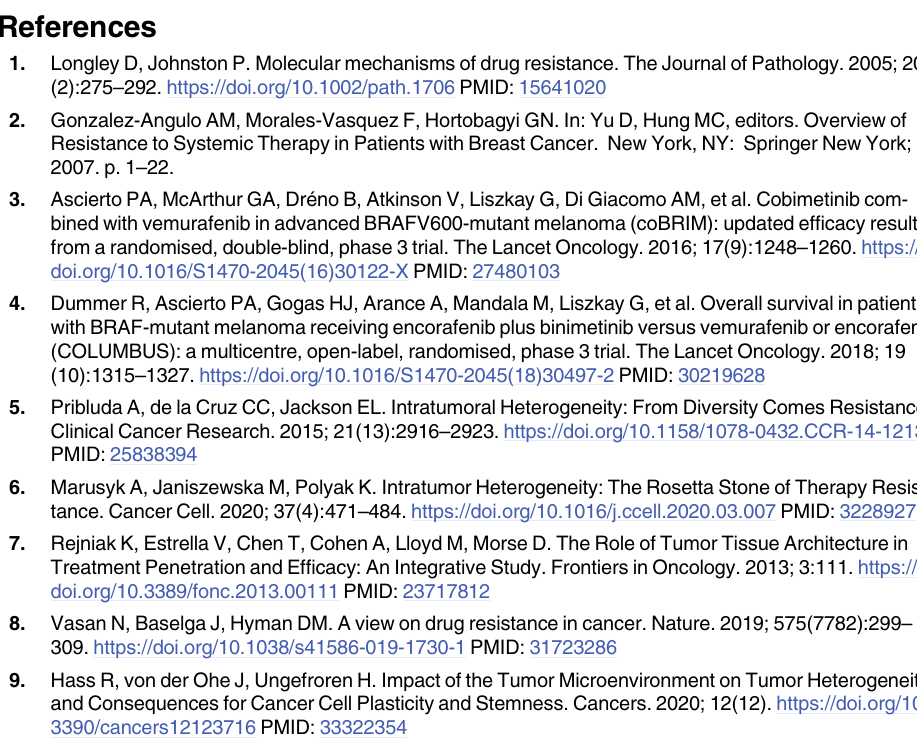
S4 Movie. Temporal change of cell configurations of different metastatic lesions for case I (Fig 11) with random invisible metastasis. The red, blue, and white dots correspond to R- cells, S-cells, and empty sites respectively. The gray dots show the sites that are accompanied by CAFs. The first and second row show results for CT-MTD and AT respectively.